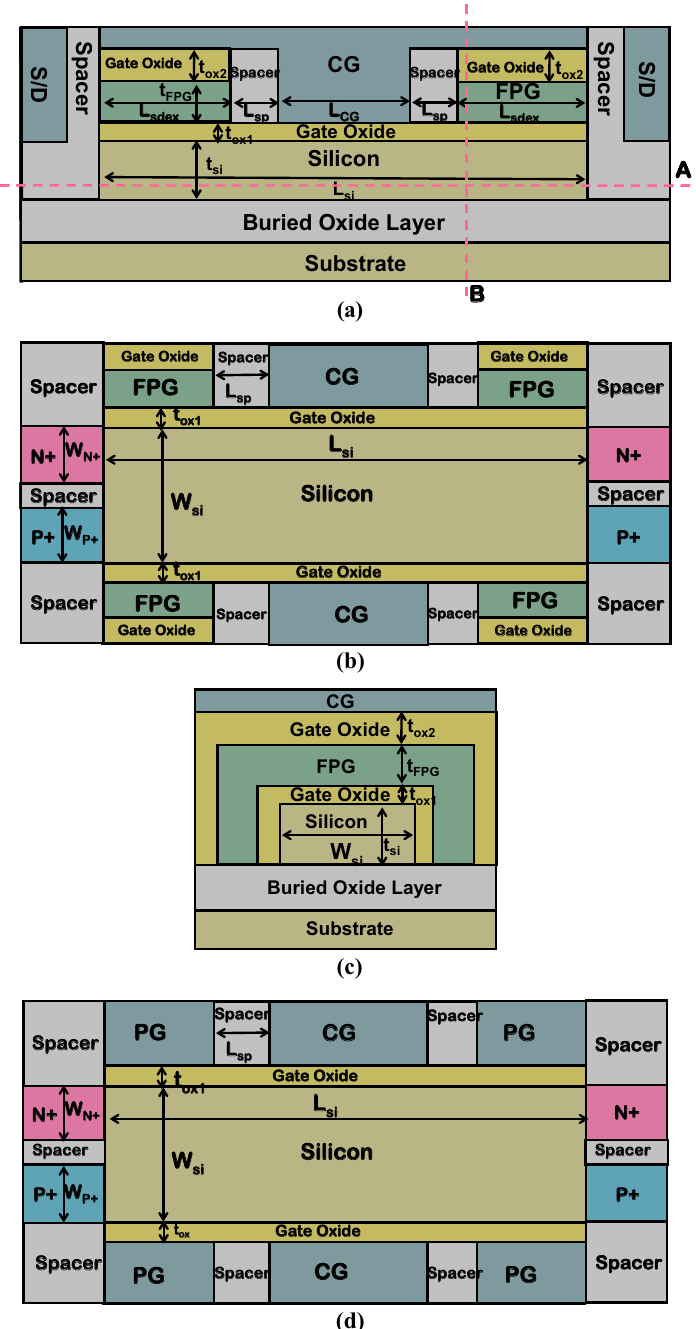
Figure 1. ( a ) A cross view of DDN R-FET. ( b ) The cross view of DDN R-FET along cutline A in Fig. 1a. ( c ) The cross view of DDN R-FET along cutline B in Fig. 1a. ( d ) A schematic view of DD